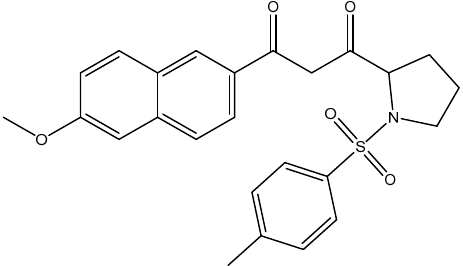
Figure 13. Structure of 1-(6-methoxynaphthalene-2-yl)-3-(1-tosylpyrrolidine-2-yl) propane-1,3-dione.